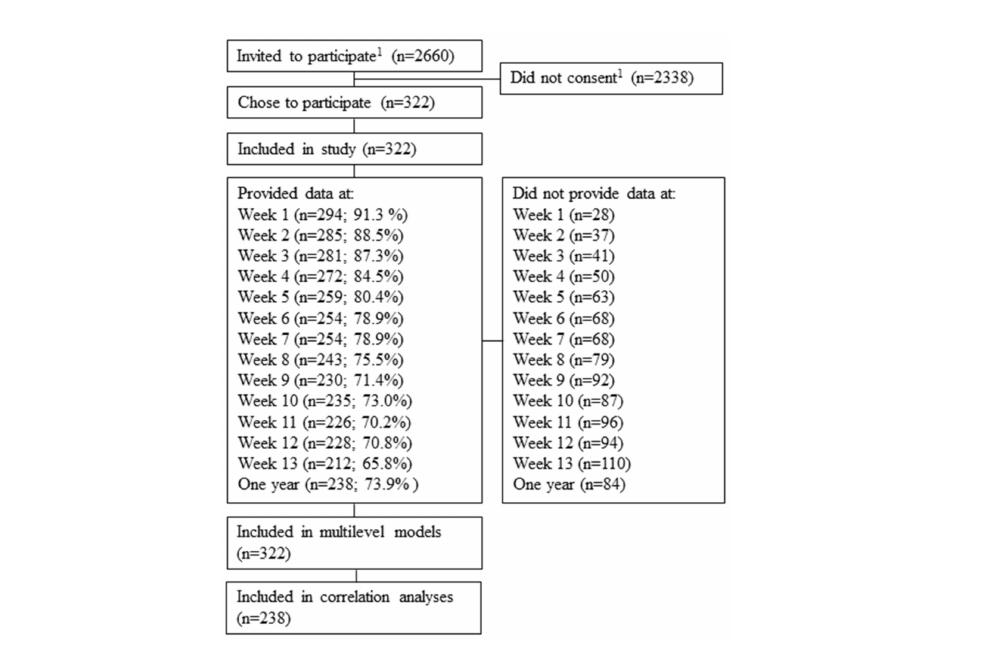
Figure 1. Flow of participants throughout the study. Notes: 1 = we do not know how many actually received the information and fulfilled the criteria of eligibility (graduating + starting to work in the upcoming weeks). Table 1. Total number of expected and actual responses week 1–13 and one year into a profession.